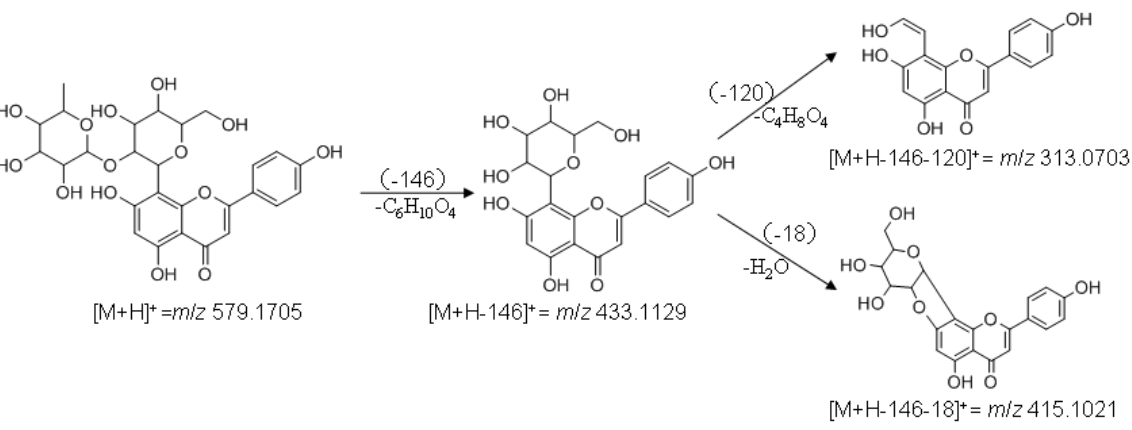
Figure 8. Main fragmentation pathways of compound